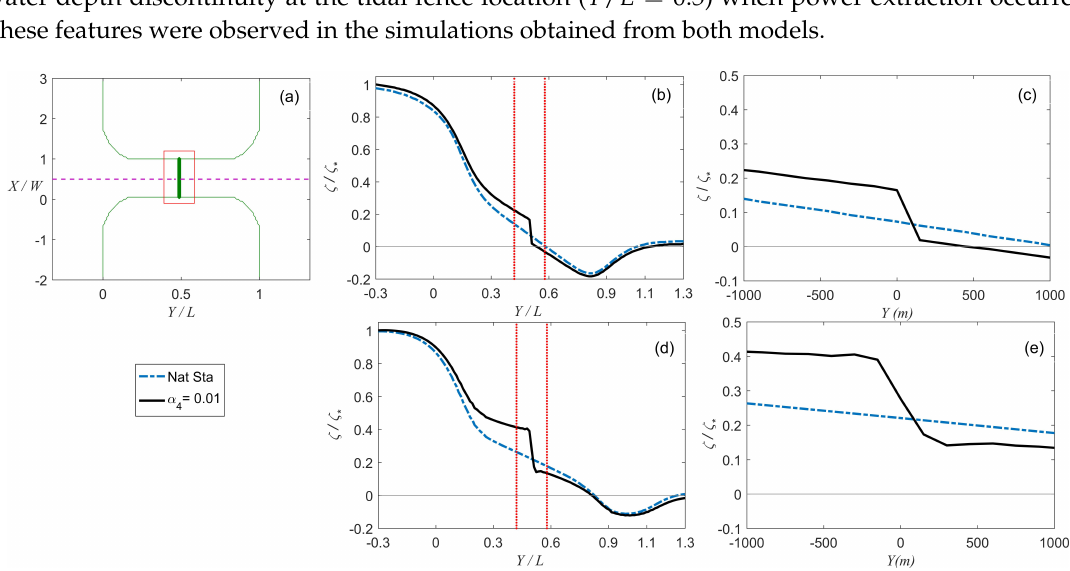
Figure 6. Plan view of the channel and stream-wise transect indicator ( a ). Transverse view of normalised water elevation profiles along the stream-wise transect obtained with ADI ( b , c ) and TVD ( d , e ). Nat Sta, natural